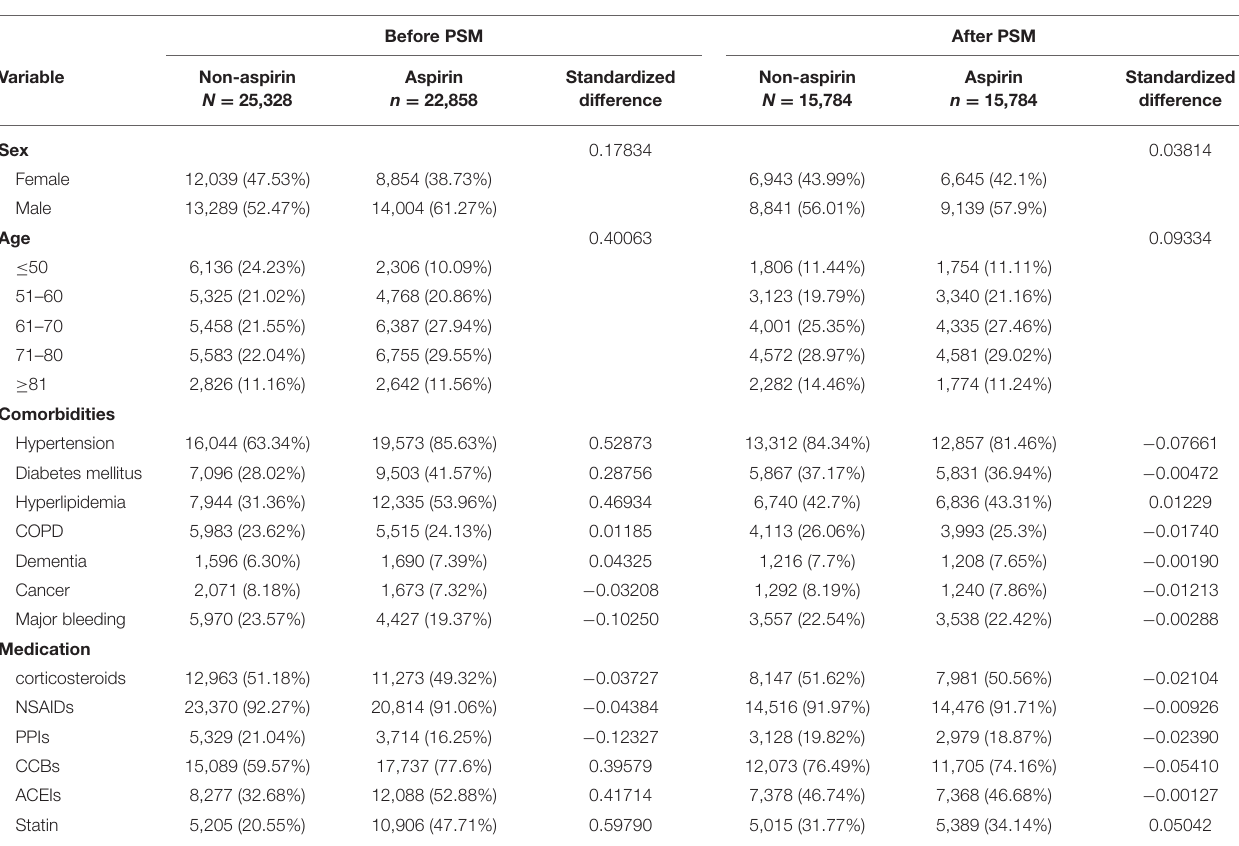
TABLE 1 | Baseline characteristics among study